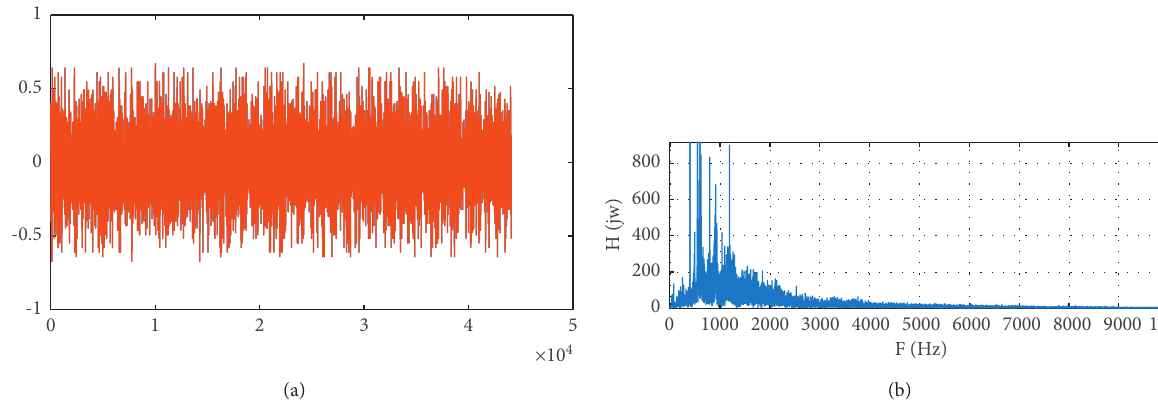
Figure 2: (a) Time-domain waveform of signal. (b) Spectrum of